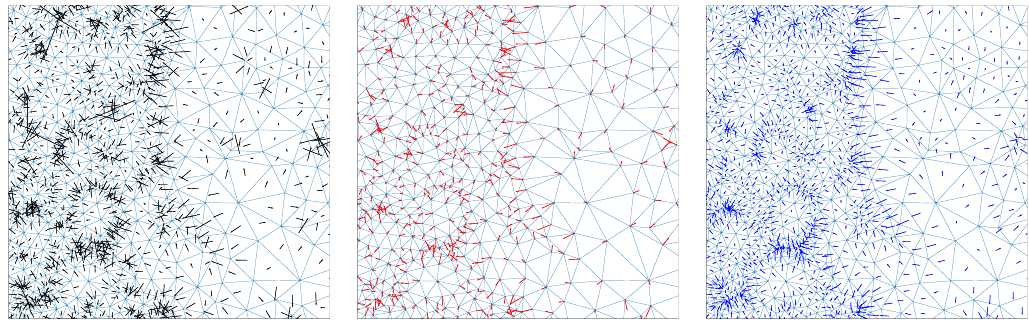
˜ ~G Figure 10 . Left panel: rescaled gradient vectors α computed via triangulation wombling, after applying one Lloyd iteration to the original data. Middle panel: the result h ~G i i from averaging the ˜ ~G gradient vectors α shown in the left panel at each data point P i according to eq. (3.9). Right panel: the result h ~G i α from further averaging the Voronoi-averaged gradient vectors h ~G i i shown in the middle panel at each Delaunay triangle according to eq.